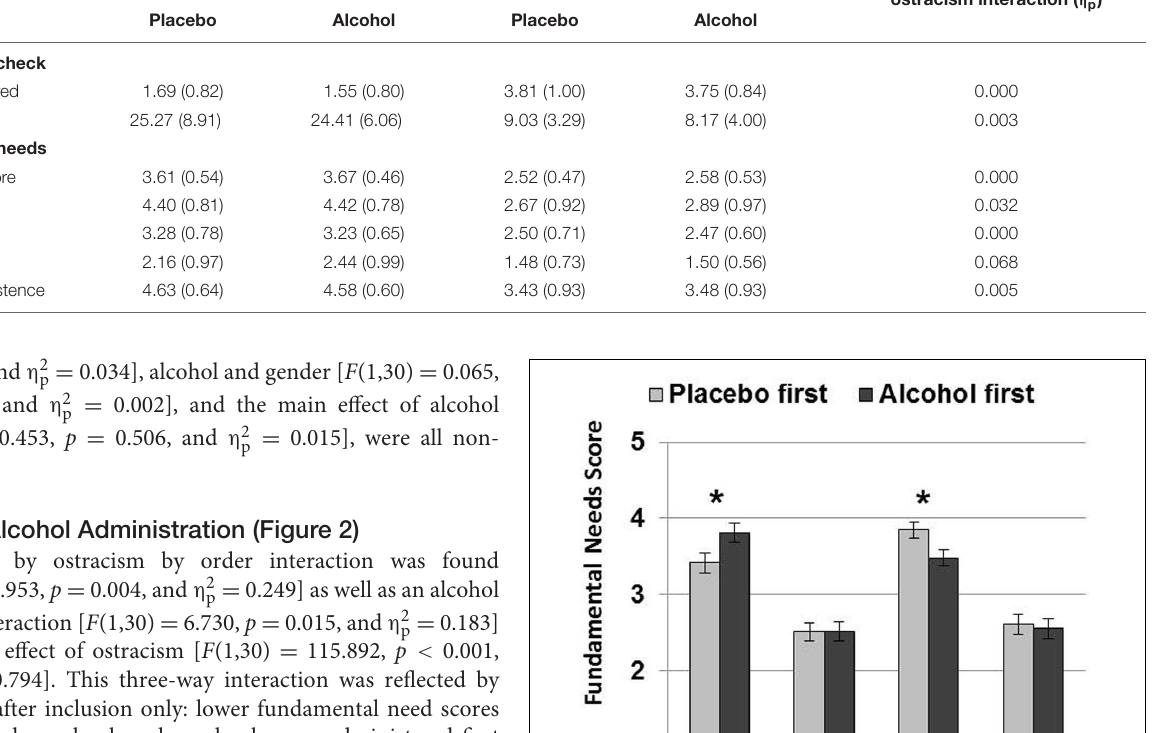
TABLE 1 | Scores from the Cyberball task before and after simulated social ostracism, following administration of placebo and alcohol. Inclusion Ostracism Alcohol administration by ostracism interaction ( η 2 p )